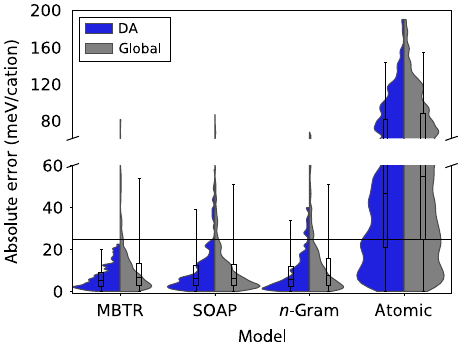
Fig. 3 DA versus global ML-model performance. Comparison of absolute error distributions for entire test set (global/gray) and for DA validation sets (DA/blue) using violin plots that extend to the 98th percentile. Boxplots inside violin plots indicate 25th, 50th, and 75th percentiles (boxes) of the absolute errors, as well as 5th and 95th percentiles (whiskers). Horizontal line indicates reference error level of half of the mean energy difference between the minimum energy and the second-to- minimum energy polymorph (mean over all considered